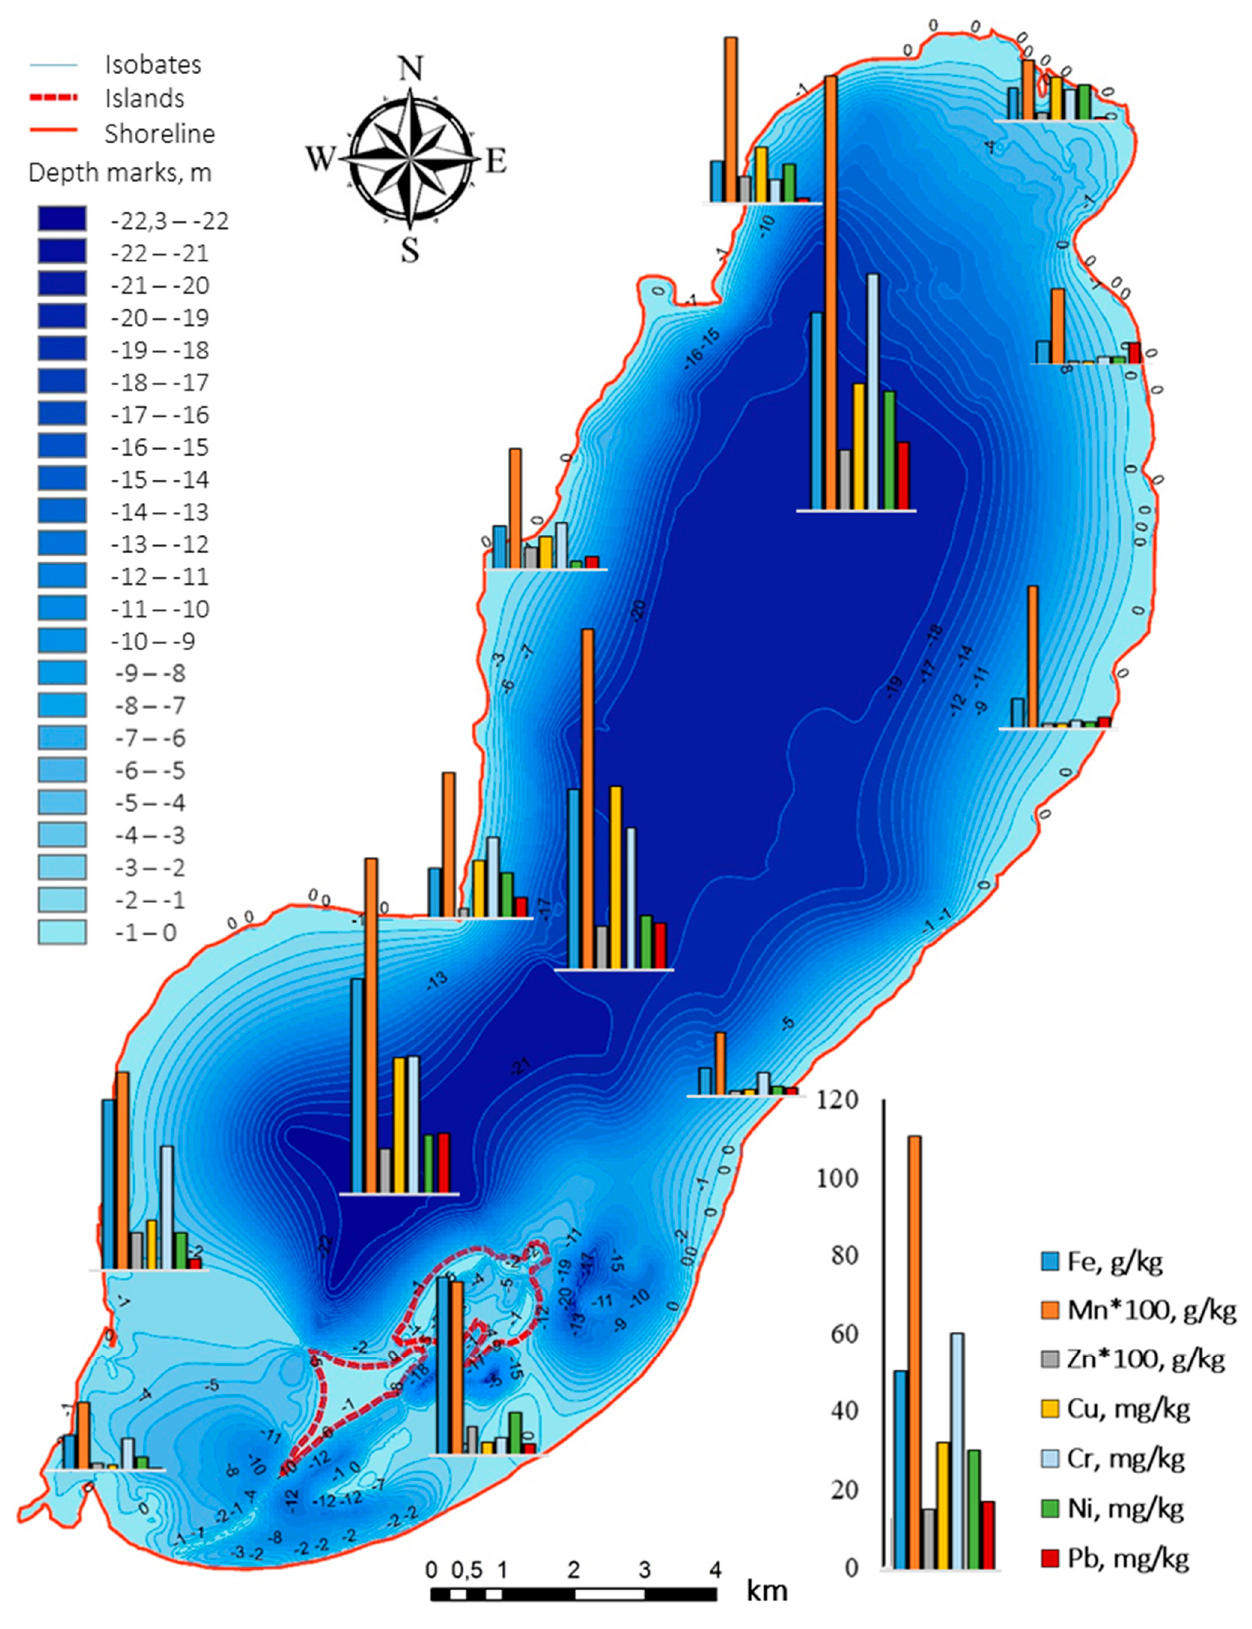
Figure 8. Content of metals in bottom sediments of Lake